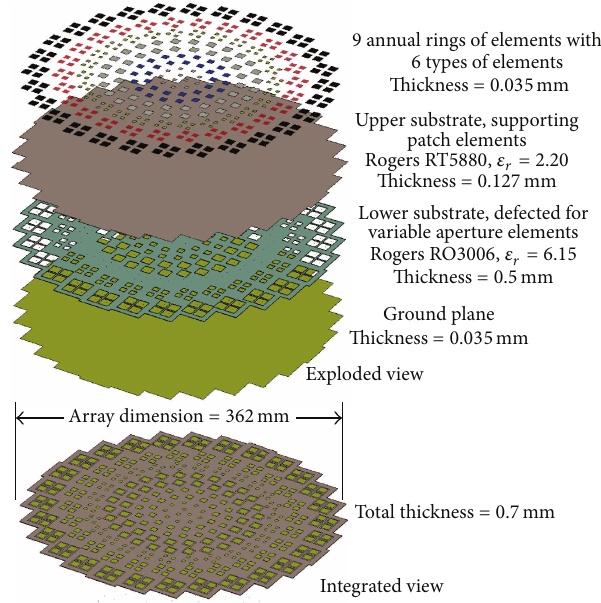
Figure 8: Detailed structure of proposed sparse array.